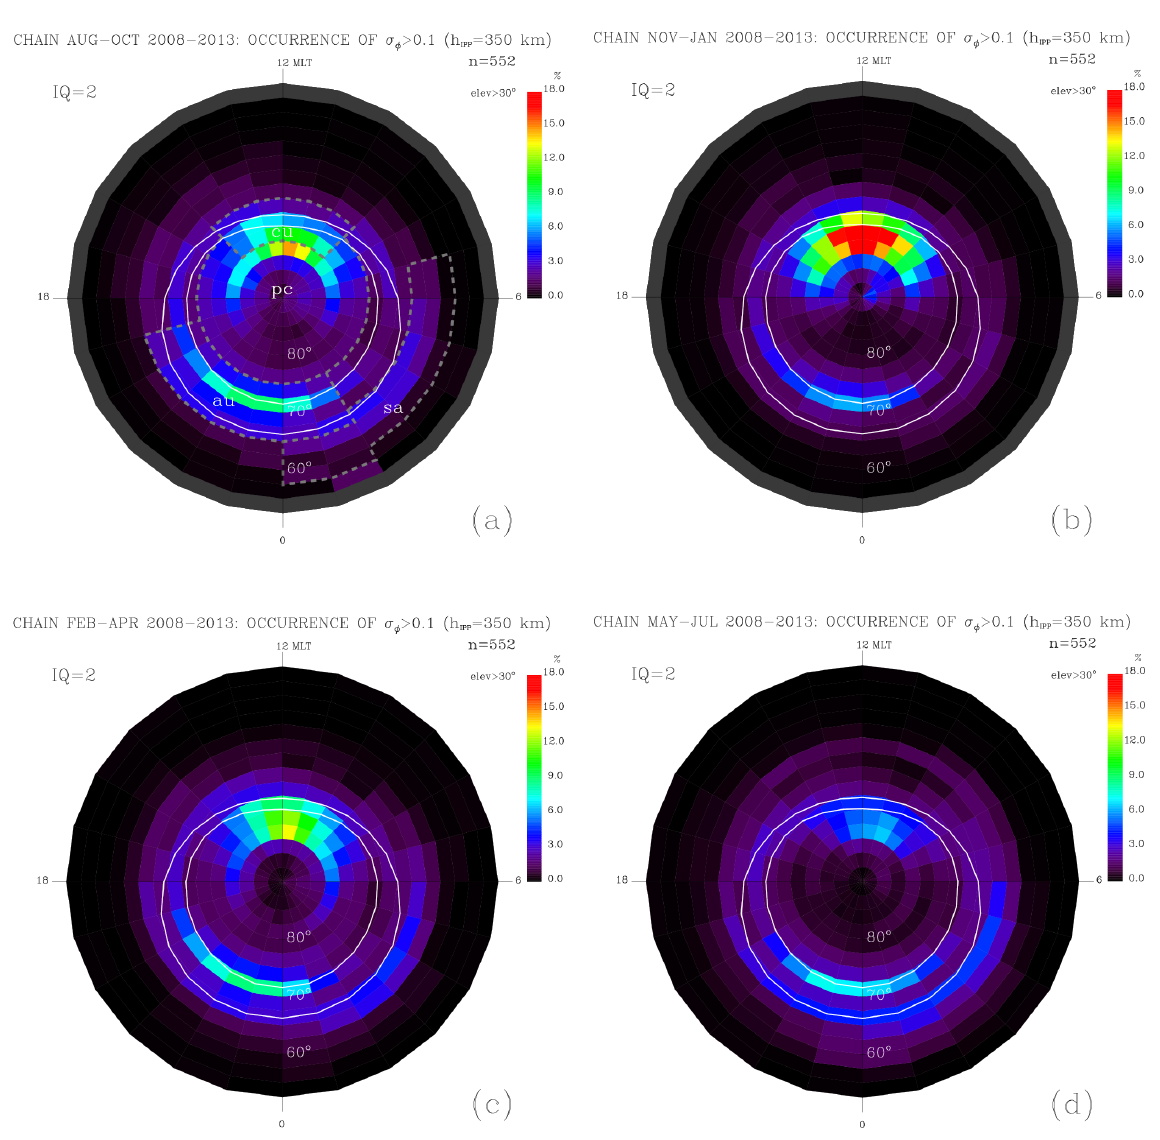
Figure 4. Phase scintillation occurrence maps ( h IPP = 350km) for (a) autumn, (b) winter, (c) spring and (d) summer. Regions identified as cusp (cu), polar cap (pc), nightside auroral oval (au) and post-midnight auroral/subauroral region (sa) are outlined in gray dashed lines in panel (a)